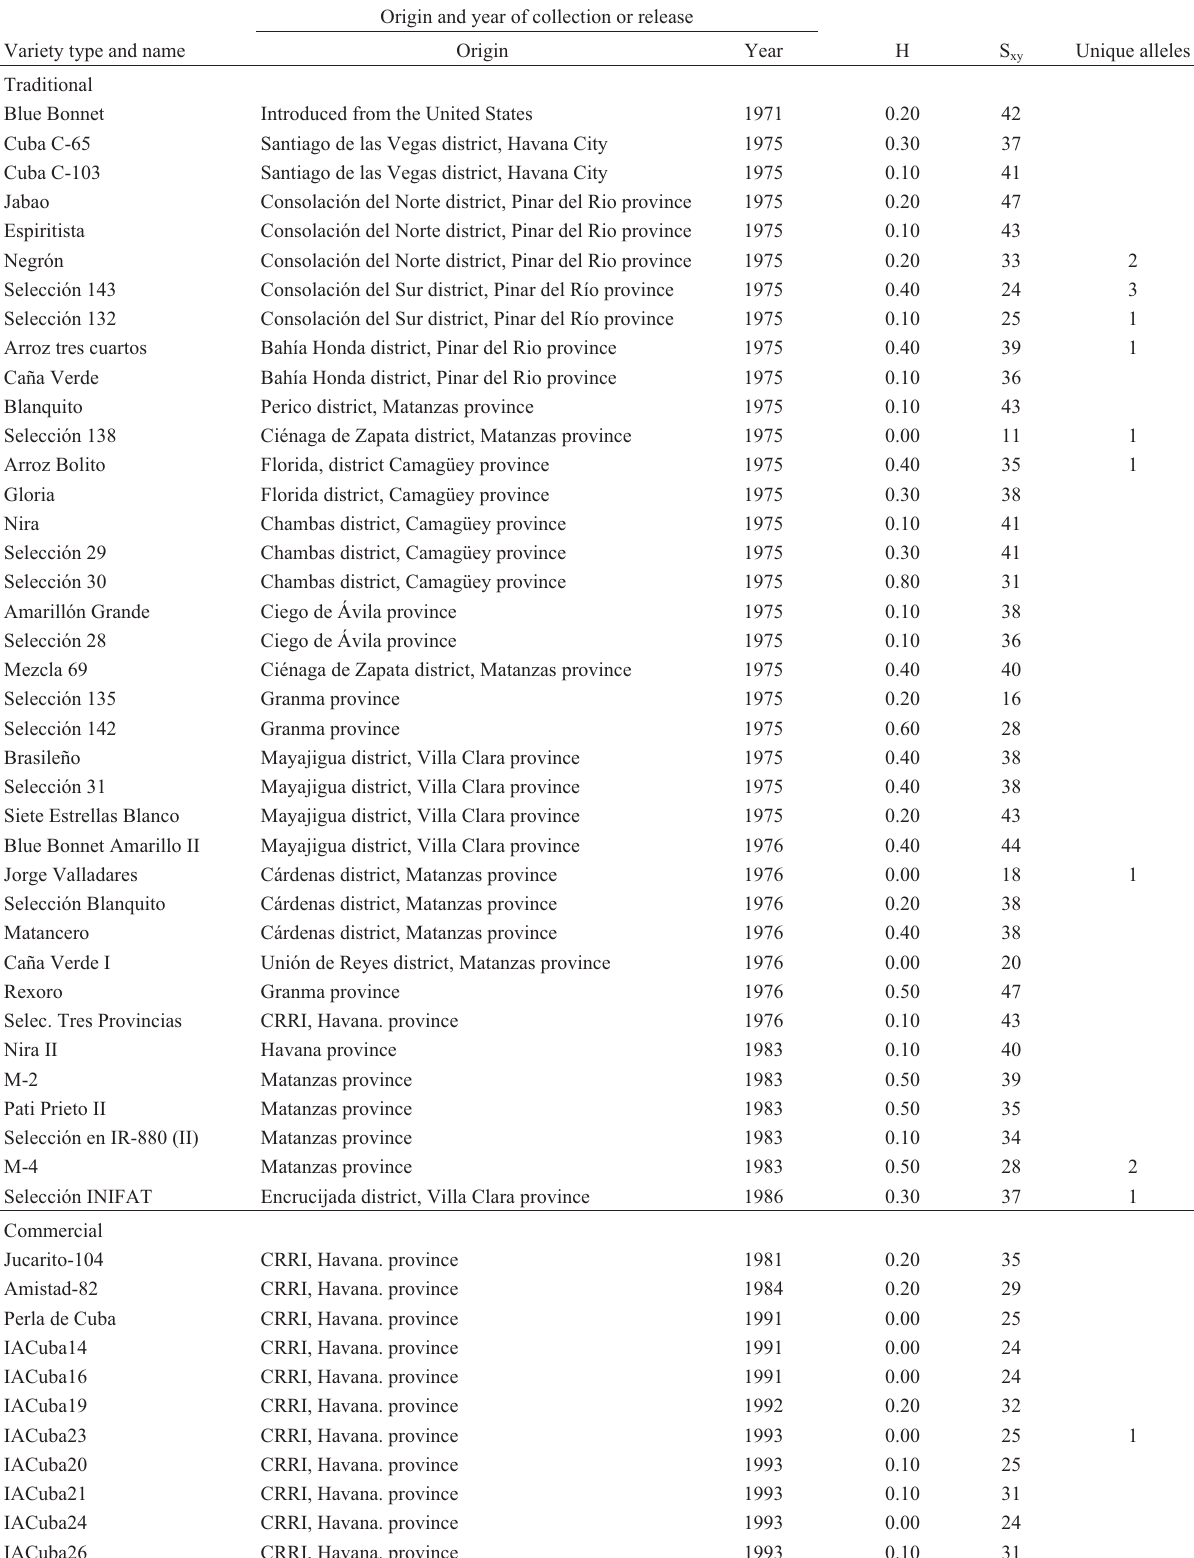
Table 1 - Characteristics of the 50 Cuban rice varieties held at the Cuban Rice Research Institute (CRRI) and used in the present study. Heterozygosity (H) expressed as the percentage of loci at which the genotype was heterozygous out of the total of 10 possible loci. Mean proportion of microsatellite loci with shared alleles (S xy ). Ordered by date and province, unless otherwise indicated, all varieties came from